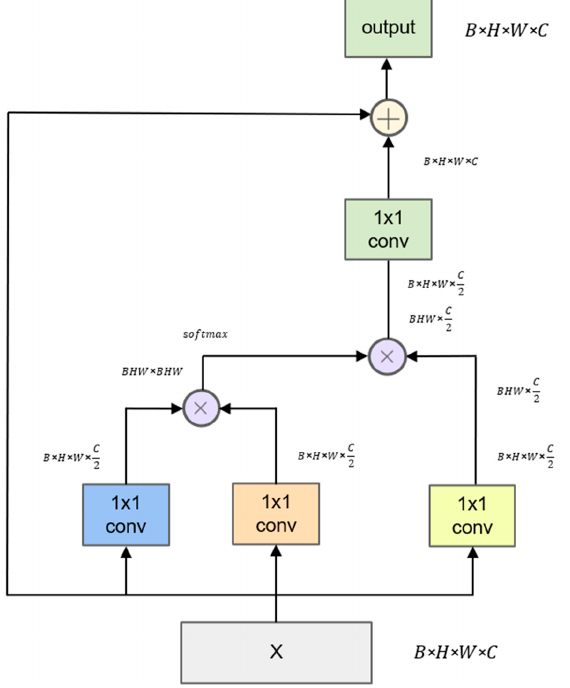
Figure 7. A non-local block. 𝐵 × 𝐻 × 𝑊 × 𝐶 represents the feature map with a batch size of B, length H, width W, and number of channels C. “ ⊗ ” denotes matrix multiplication, and “ ⊕ ” denotes element-wise sum.